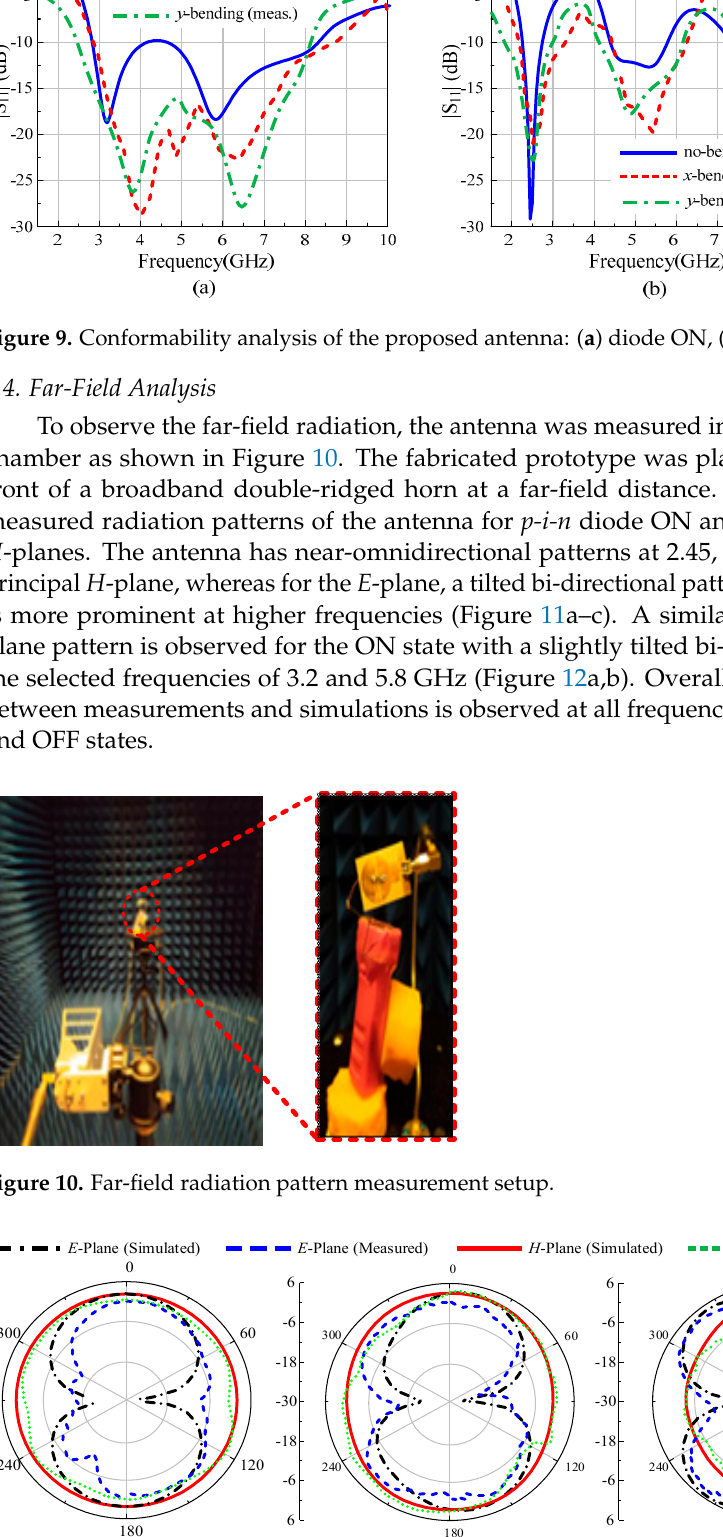
Figure 8. Antenna under conformal condition: ( a ) bending along the x -axis and ( b ) bending along the y -axis.